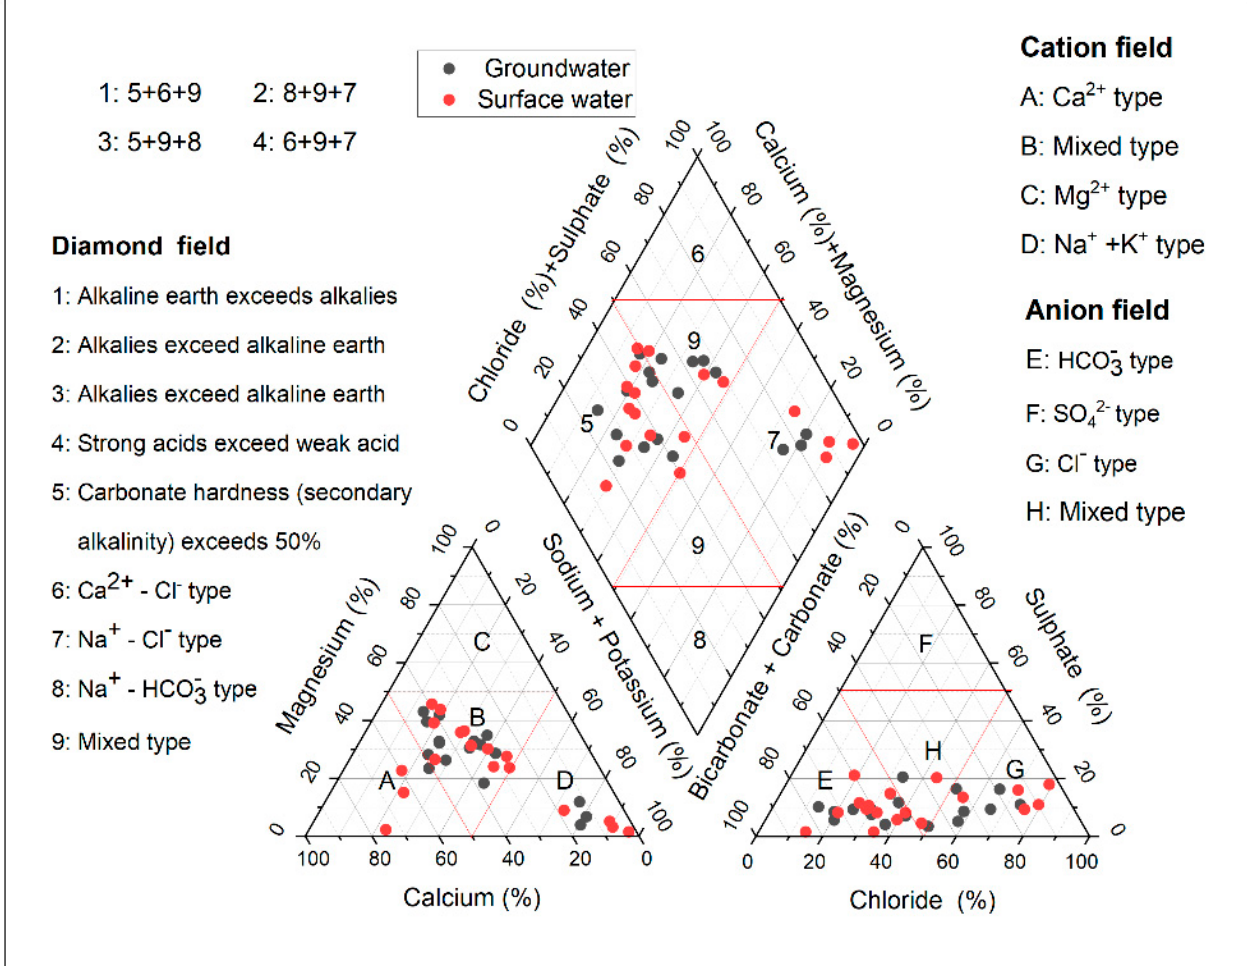
Figure 4. Piper tri-linear diagram showing the hydrochemical facies of the study area.